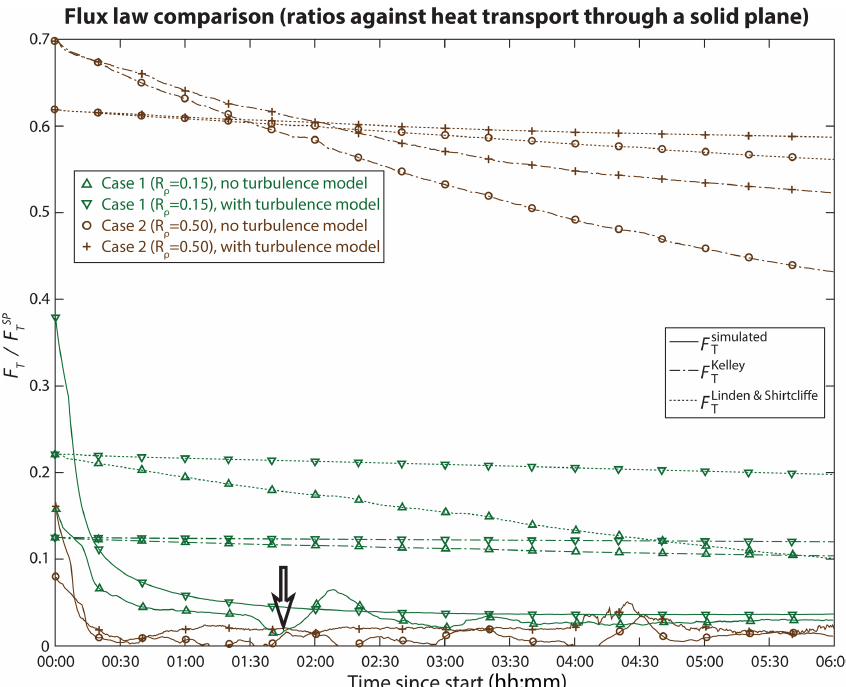
Figure 10. Simulated and theoretical heat fluxes according to Eqs. (27) and (28) relative to the theoretical heat flux through a solid plane (Eq. 29). Green colours represent the results for Case 1 and brown colours represent the results for Case 2. The open arrow marks the moment that the simulated heat flux starts rising towards the theoretical flux laws in the simulation of Case 1 without a turbulence model.